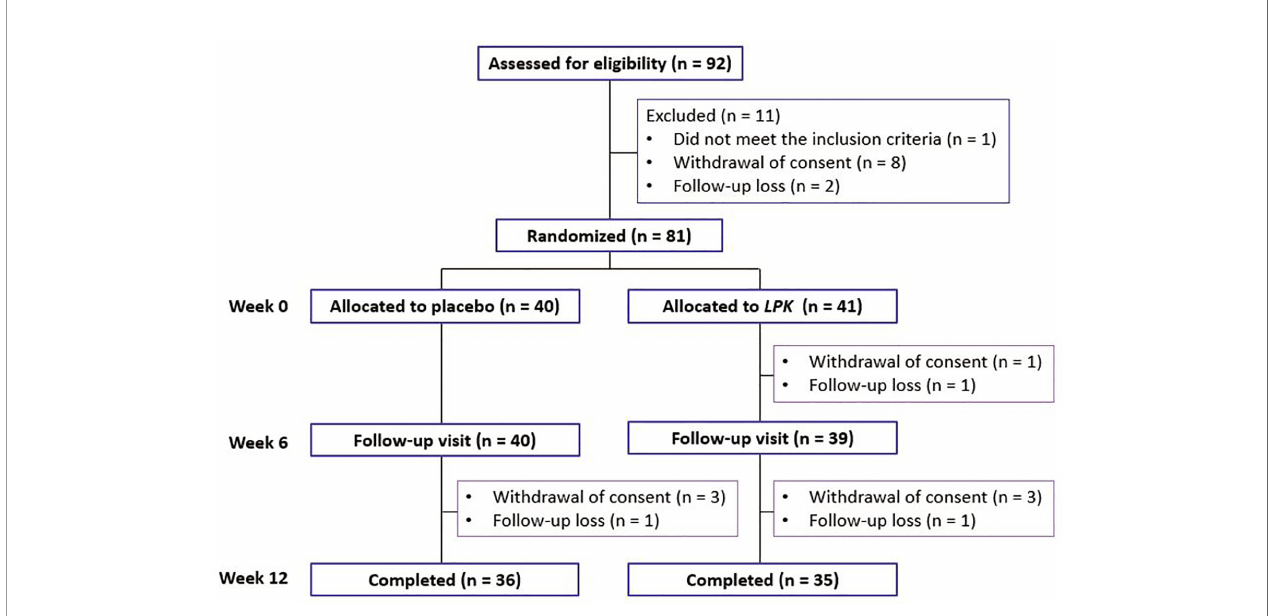
FIGURE 1 | Distribution of the study participants during the study period. LPK, Lactobacillus plantarum